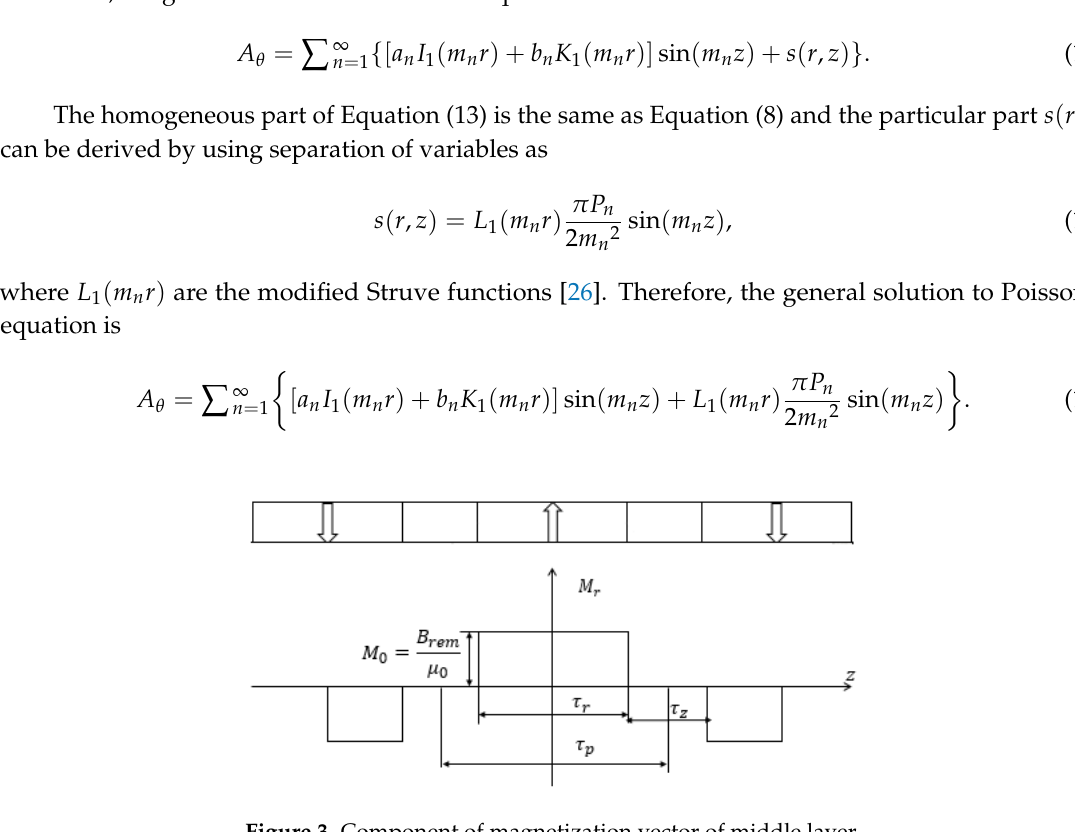
Figure 3. Component of magnetization vector of middle layer.